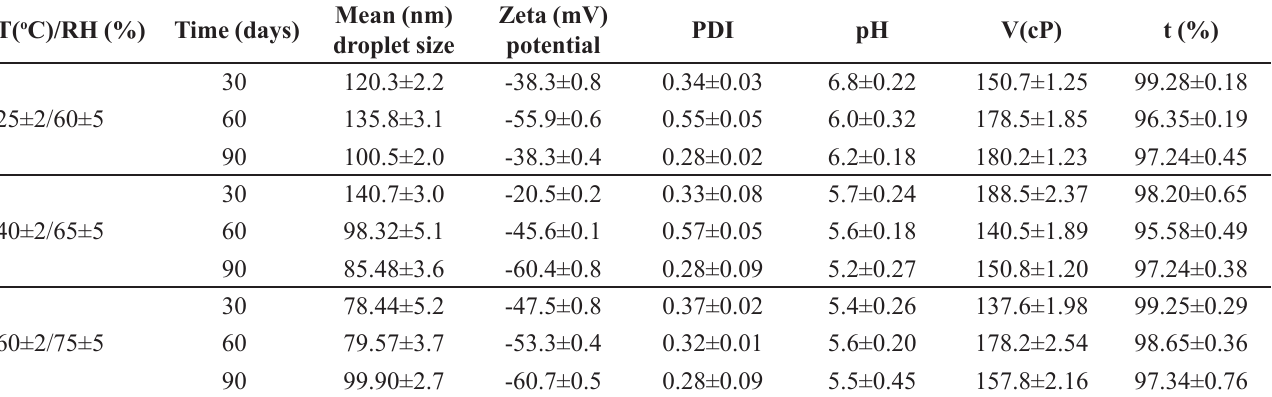
TABLE V - Stability study of Optimized Nanoemulsion (NE4) T( o C)/RH